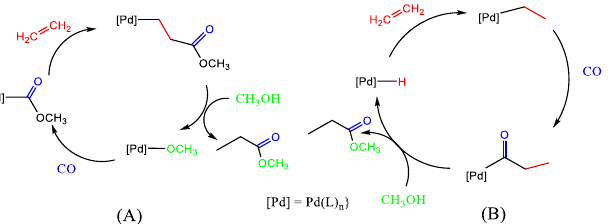
Figure 2. Products obtained from the palladium-catalysed reaction of ethene, carbon monoxide, and methanol according to Drent et al.